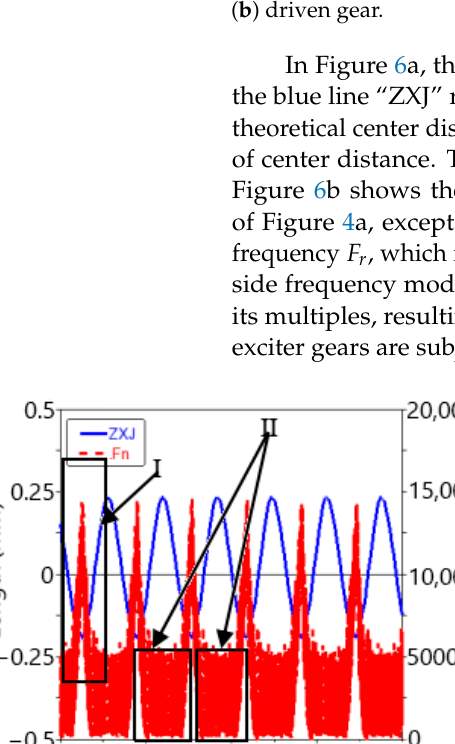
Figure 5. Position curve of gear rotation center in x’ y’ coordinate system. ( a ) Driving gear and ( b ) driven gear.